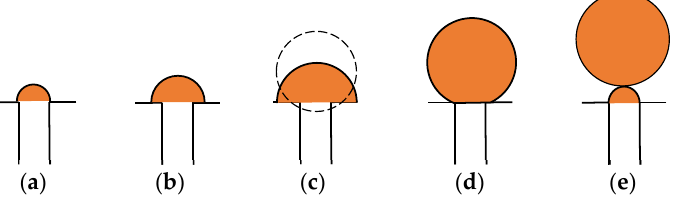
Figure 9. The growth physical model of a bubble [37]: ( a ) The bubble nucleus; ( b ) the spherical propagation of the bubble; ( c ) the transition stage; ( d ) the contraction of the bubble; ( e ) a bubble separating from porosity with new nucleus left.